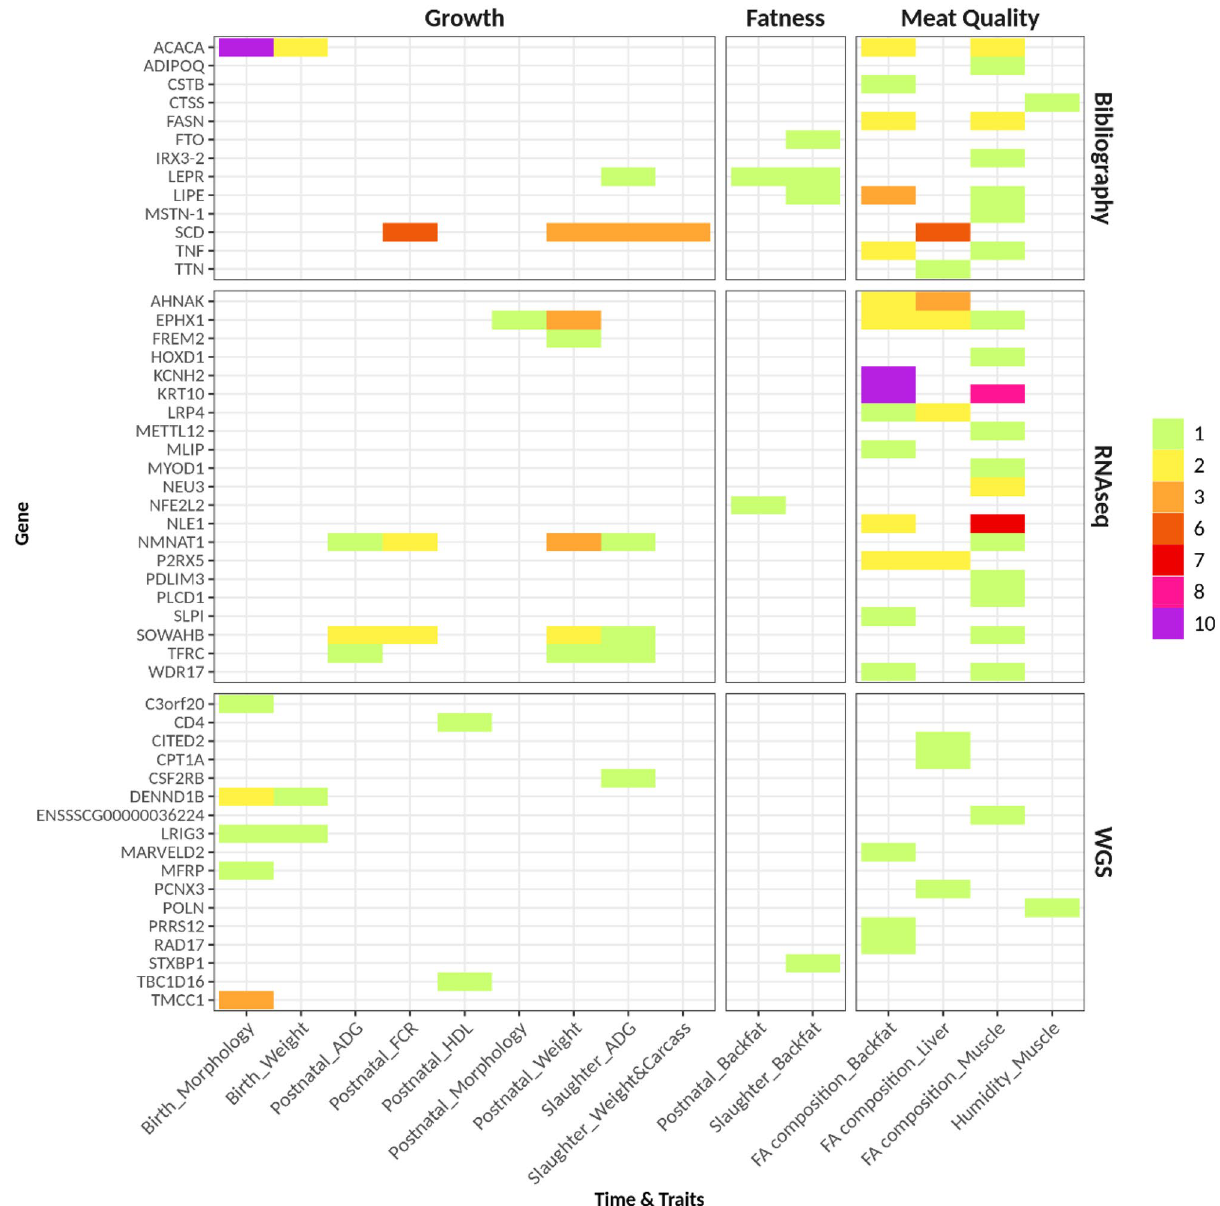
Figure 3. Summary of significant association results (q < 0.10) obtained for the different traits, grouped by trait type/stage (x axis) and source of polymorphisms (y axis). Colored bars denote the number of traits significantly associated with each gene. ADG average daily gain, FCR feed conversion ratio, WGS whole genome